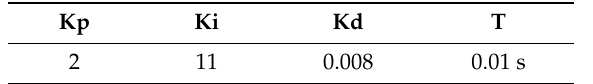
Table 2. Gains from proportional–integral–derivative (PID) DC motor controller.